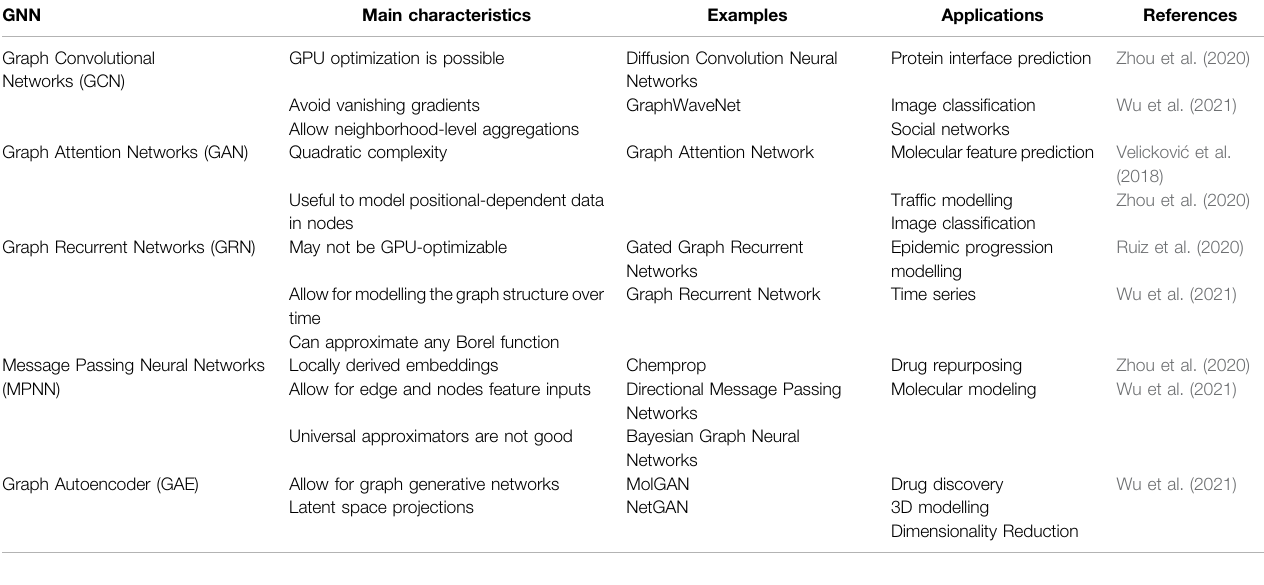
TABLE 1 | Summary of main graph neural network architectures.